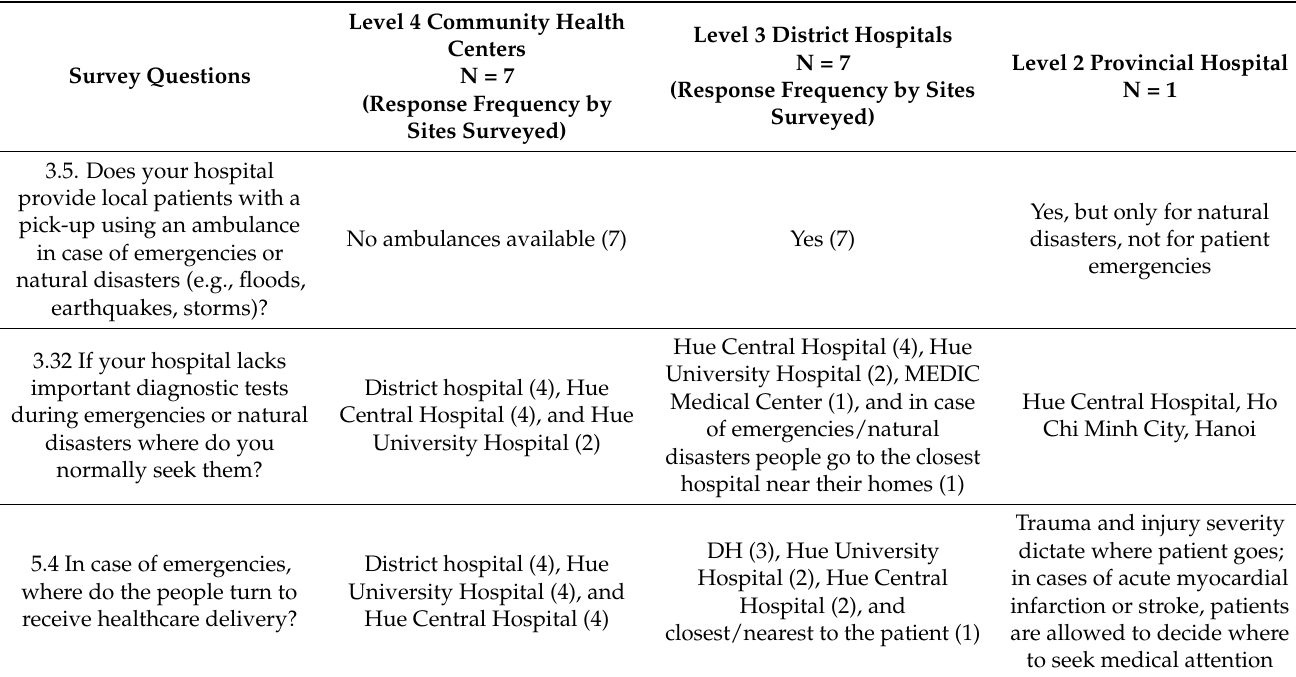
Table 4. Acute medical response in the case of an emergency or natural